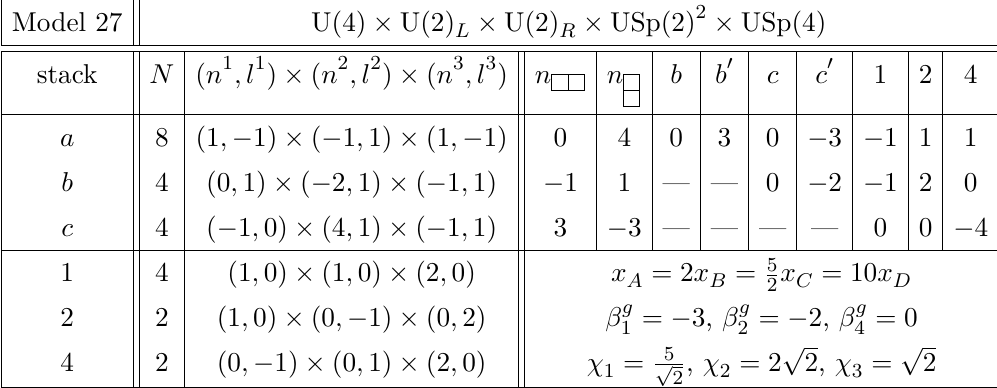
Table 34 . D6-brane configurations and intersection numbers of Model 27, and its MSSM gauge